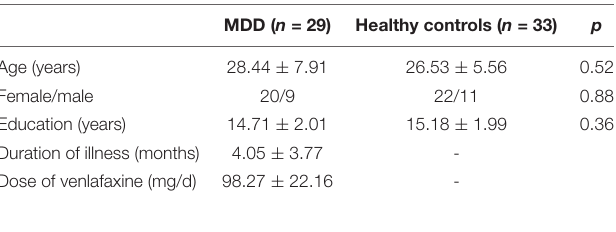
TABLE 1 | Group demographics and clinical measures (mean ± SD ).